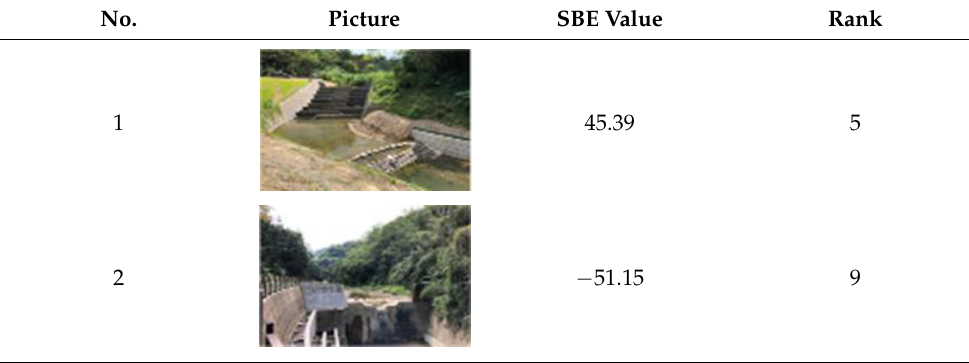
Table 9. SBE results of the “Renovation Project of Sijiaolin Stream .” .